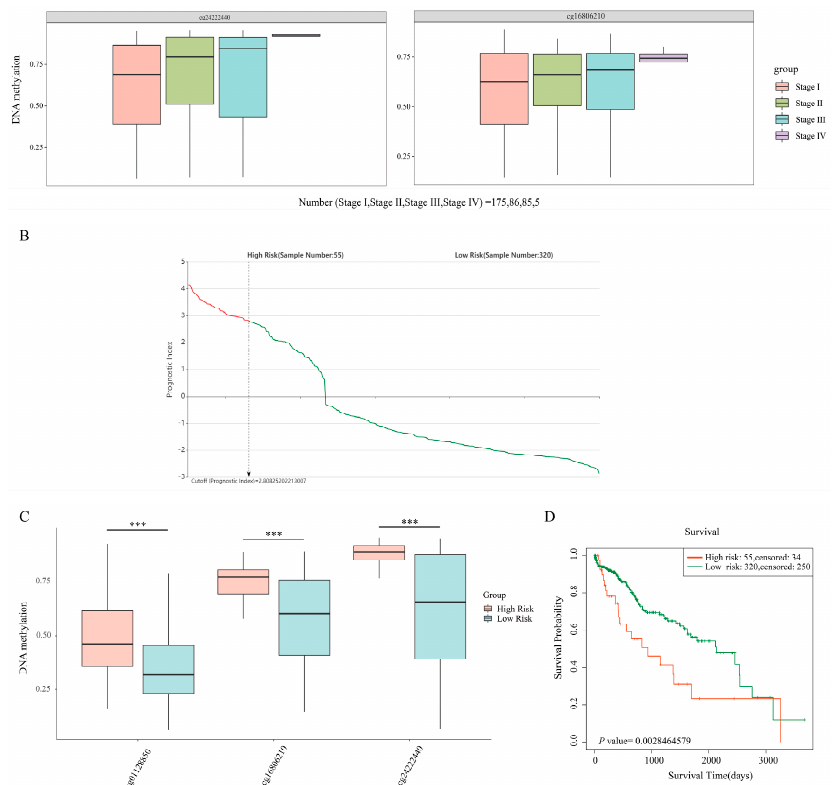
Figure 6. SurvivalMeth data showed a clinical correlation between TTC36 methylation levels. ( A ) Methylation levels of 2 CpGs (cg24222440 and cg16806210) of TTC36 in HCC cancer tissues with different pathological stages. ( B ) A total of 375 HCC patient samples were divided into high- and low-risk groups at the optimal cutoff (prognostic index) of 2.808. The prognostic index was calculated according to the DNA methylation matrix and the coefficient (obtained from the proportional hazards regression model) of TTC36, and a high level of prognostic index implies a high risk for the patient. The “red curve” indicates the high-risk group. The “green curve” indicates the low-risk group. ( C ) The methylation levels of 3 CpGs (cg01128850, cg16806210, and cg24222440) of TTC36 in the high- and low-risk groups. *** p < 0.001. ( D ) The survival curve of the Kaplan–Meier plot showed that HCC patients in the high-risk group had a lower survival probability [HR = 2.05 (1.11–3.80), p <